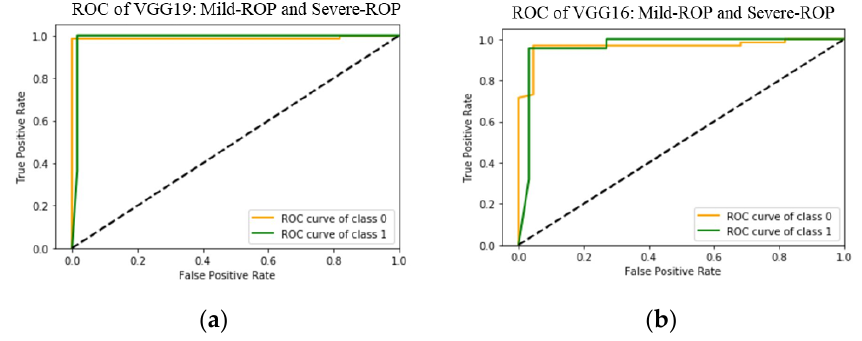
Figure 8. ROC curves of ( a ) VGG19 and ( b ) VGG16 models for classifying mild-ROP and severe-ROP. Table 9. Performance evaluation of the 5-fold cross-validation of the VGG19 model. Table 7. Confusion matrix of the test cases predicted for mild-ROP, denoted as 0, and severe-ROP, denoted as 1, by the VGG19 and VGG16 models. Classification Models